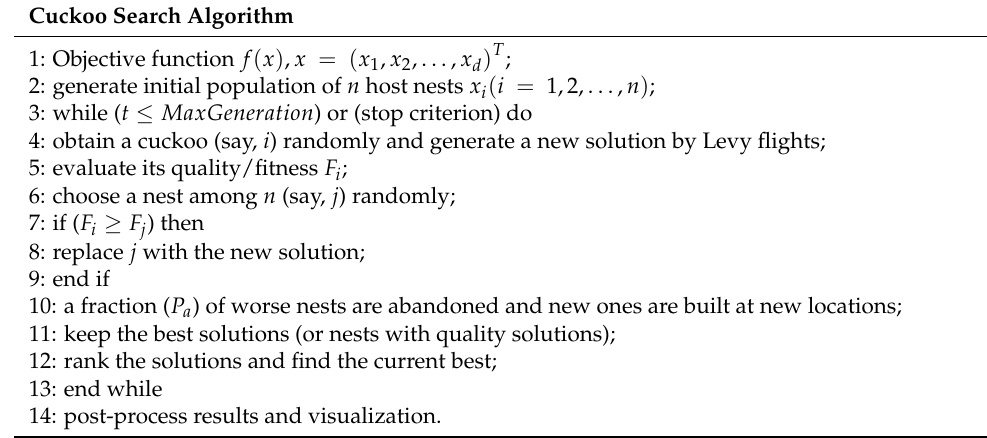
Table 5. Pseudo codes of the standard cuckoo search algorithm. Cuckoo Search